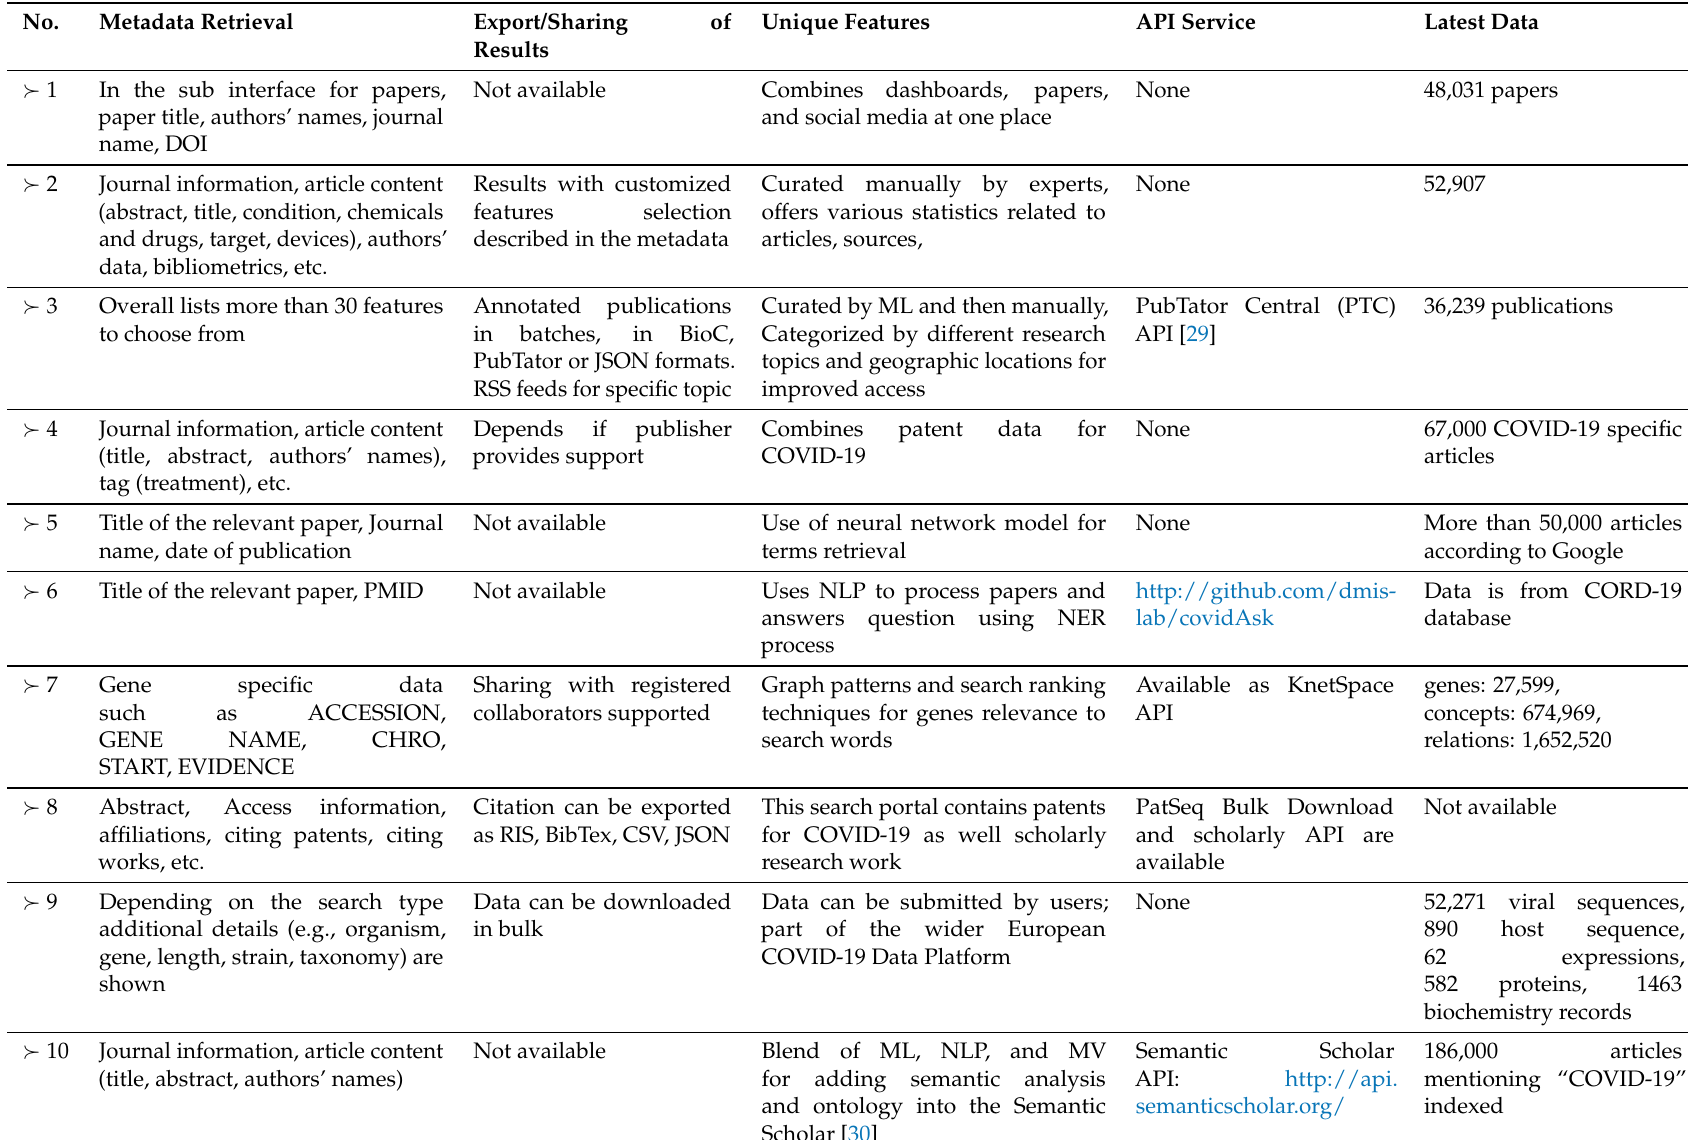
Table 3. Analysis of COVID-19 search portals using selected features (Part 3 of